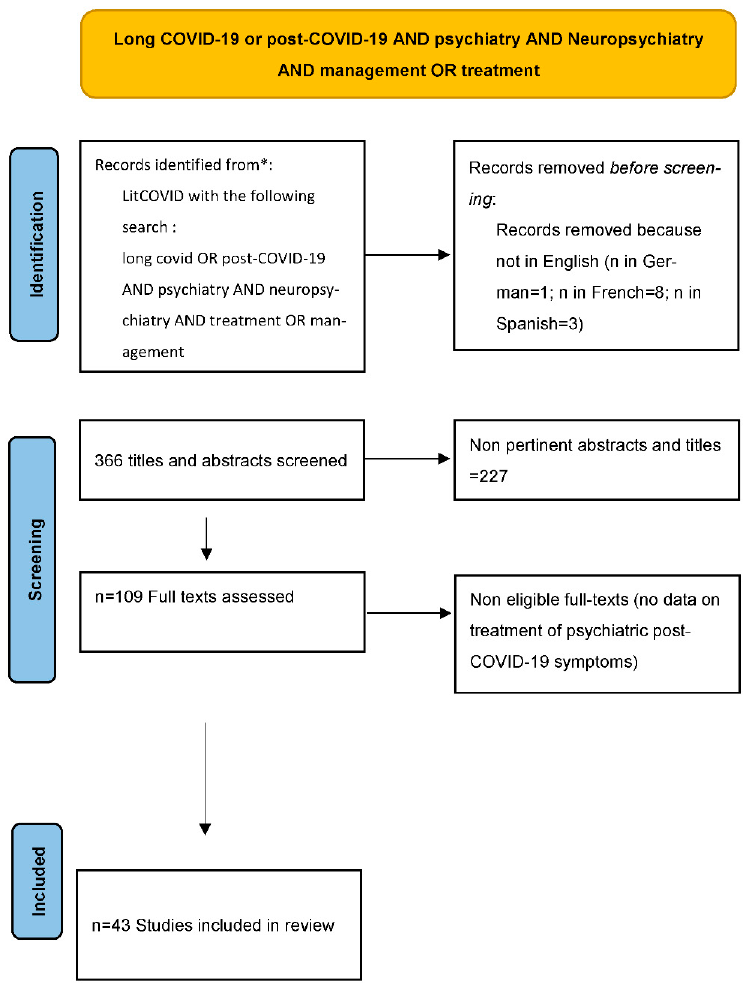
Figure 1. Flowchart of the literature search from Page et al., 2020 [24]. * Publications before 5 February 2022. Table 1. Synopsis of articles reviewed.